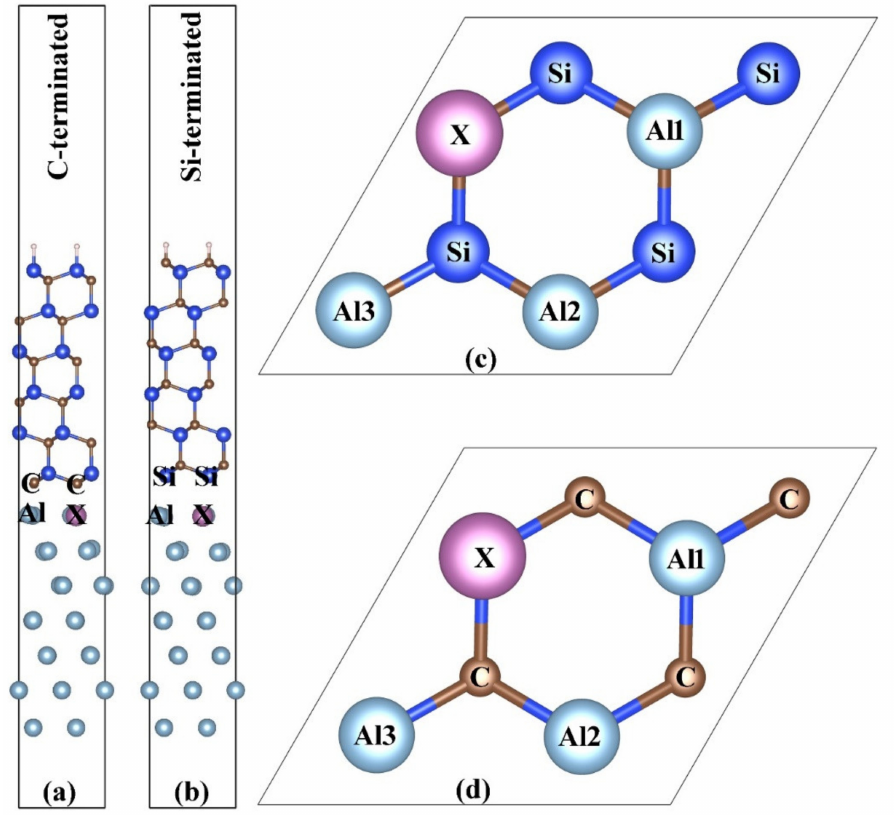
Figure 1. The 2 × 1 × 1 supercell model of Al(111)/6H-SiC(0001) interface. ( a ) Side view of the C-terminated interface; ( b ) side view of the Si-terminated interface; ( c ) top view of the C-terminated interface; ( d ) top view of the Si-terminated interface. Light-blue, brown, blue and violet spheres represent Al, C, Si and impurity atoms,